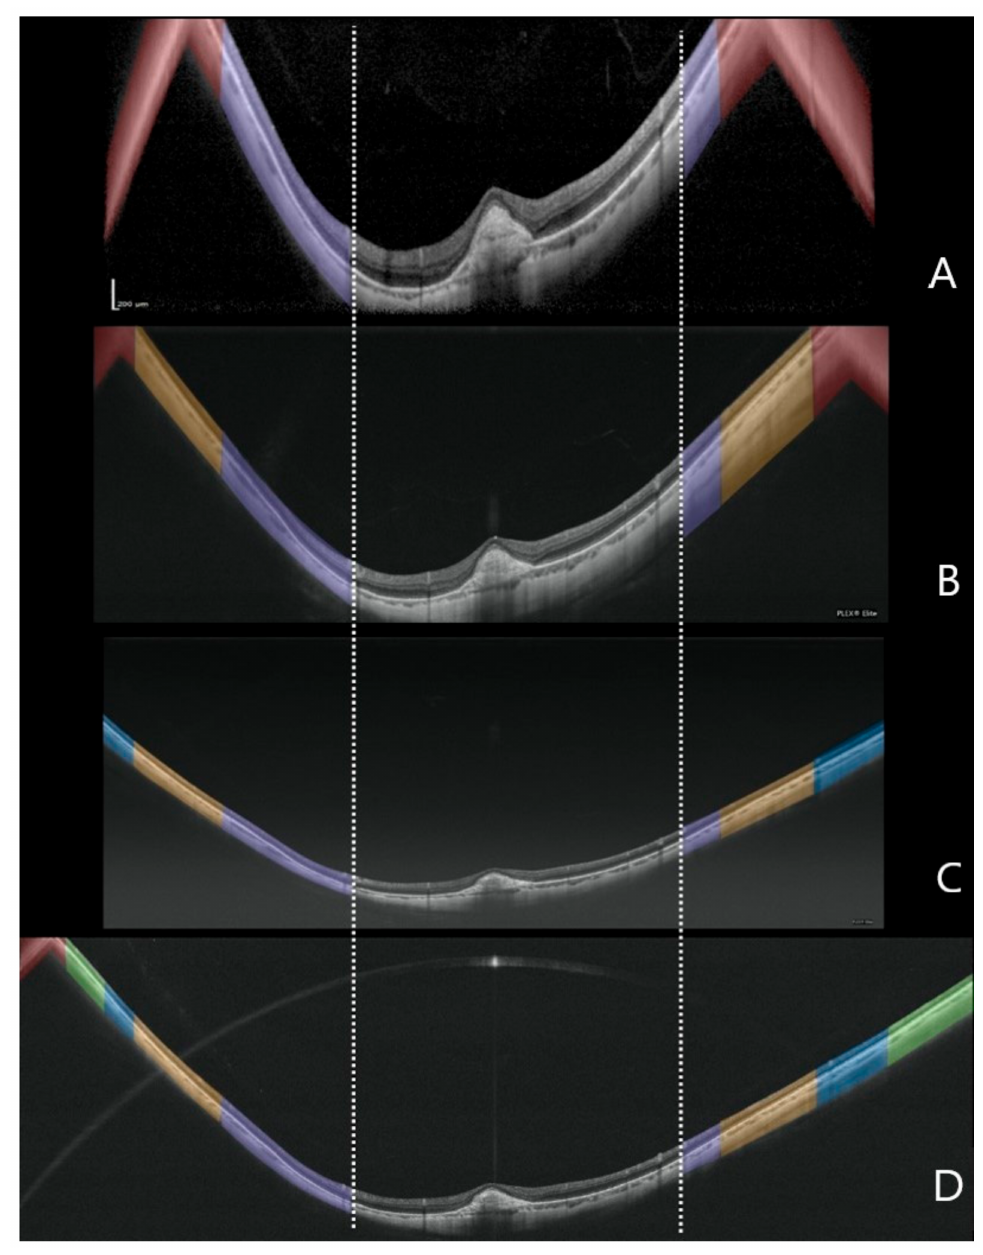
Figure 2. Representative example of a highly myopic eye imaged with four different optical coherence tomography devices. Spectralis OCT2 ( A ); Plex Elite 2.0 100 kHz ( B ); Plex Elite 2.0 200 kHz ( C ) and Canon Xephilio OCT-S1 ( D ). The purple masks show the corresponding zones of visible retina across all the devices. The orange masks indicate the additional corresponding zones of visible retina evident with the Plex Elite 2.0 100 kHz, Plex Elite 2.0 200 kHz and Canon Xephilio OCT-S1. The blue masks show the additional corresponding zones of visible retina evident only on the Plex Elite 2.0 200 kHz and Canon Xephilio OCT-S1. The green masks indicate the additional visible retina only evident with the Canon Xephilio OCT-S1. The red masks show the portion of flipped or mirror image artifact, which is not included in the quantitative